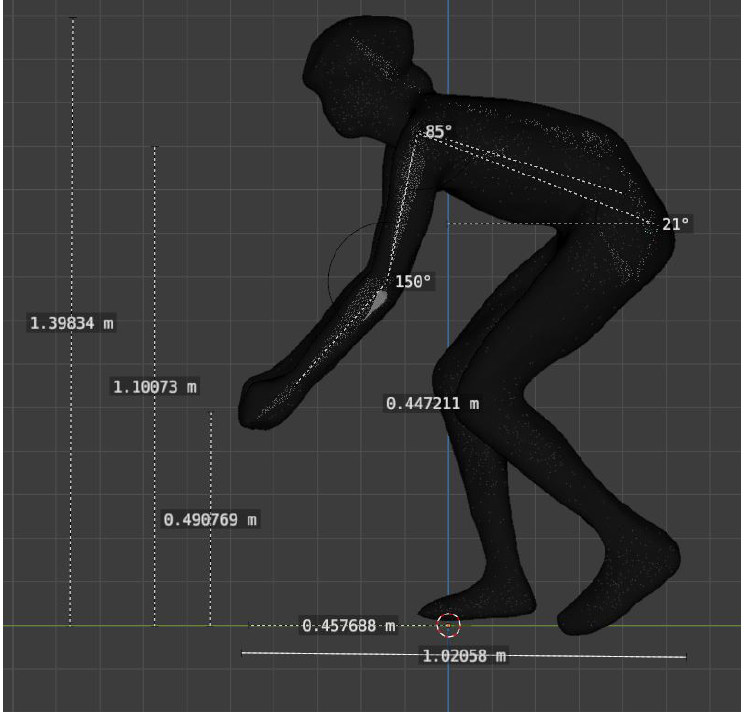
Figure 2. Detailed dimensions of the cyclist for the HD